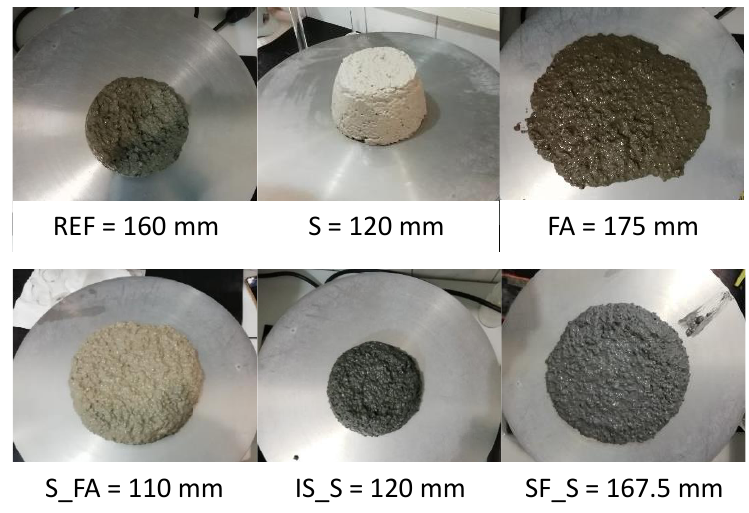
Figure 2. Visual observation of the slump for different mortars.